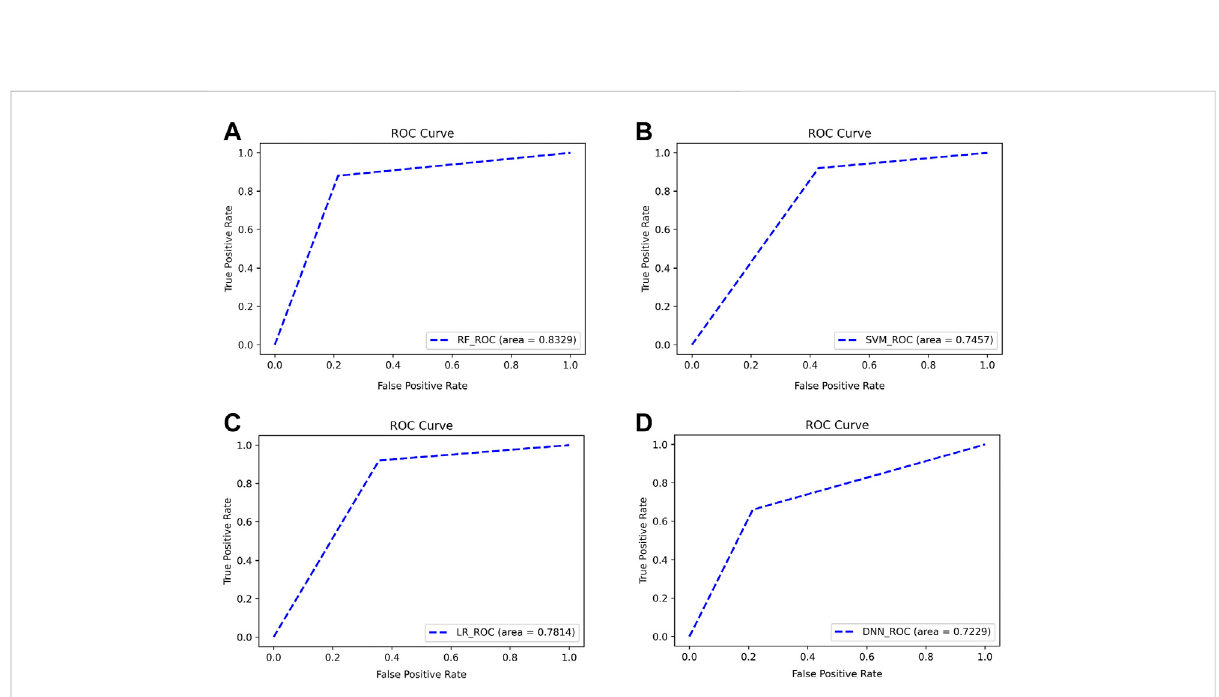
FIGURE 11 ROC curves for classifying subjects on external validation set using Top 13 features. The classi fi ers used by (A – D) are RF, SVM, LR, and DNN,